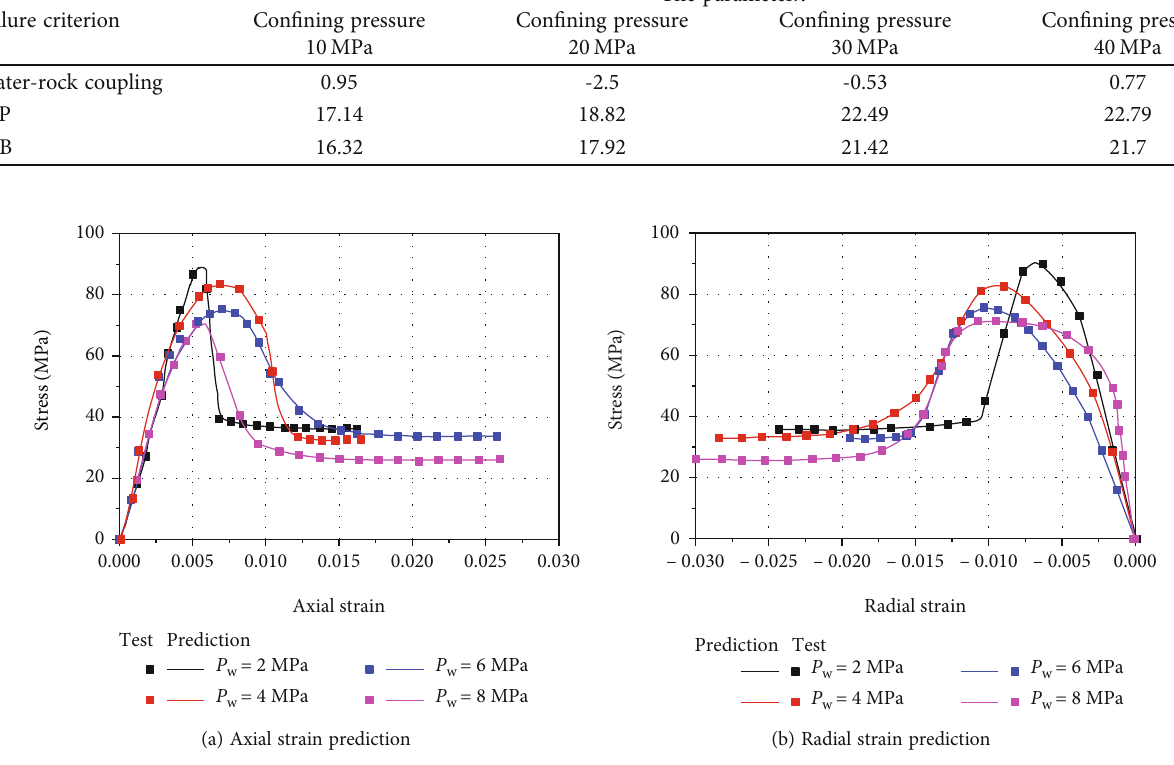
Figure 5: Comparison of preexperimental results of model-predicted